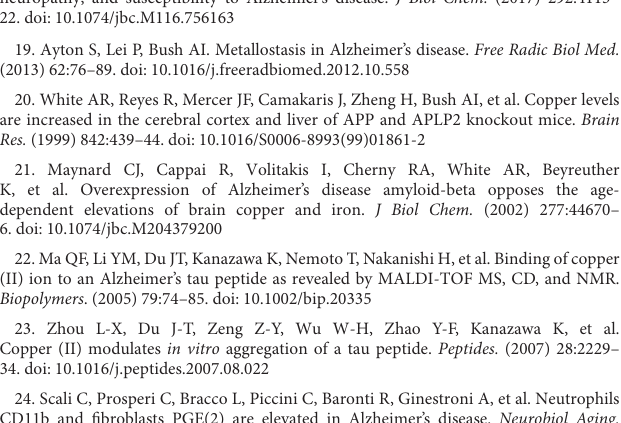
SUPPLEMENTARYFIGURE2 Protein-protein interaction of seven hub genes.